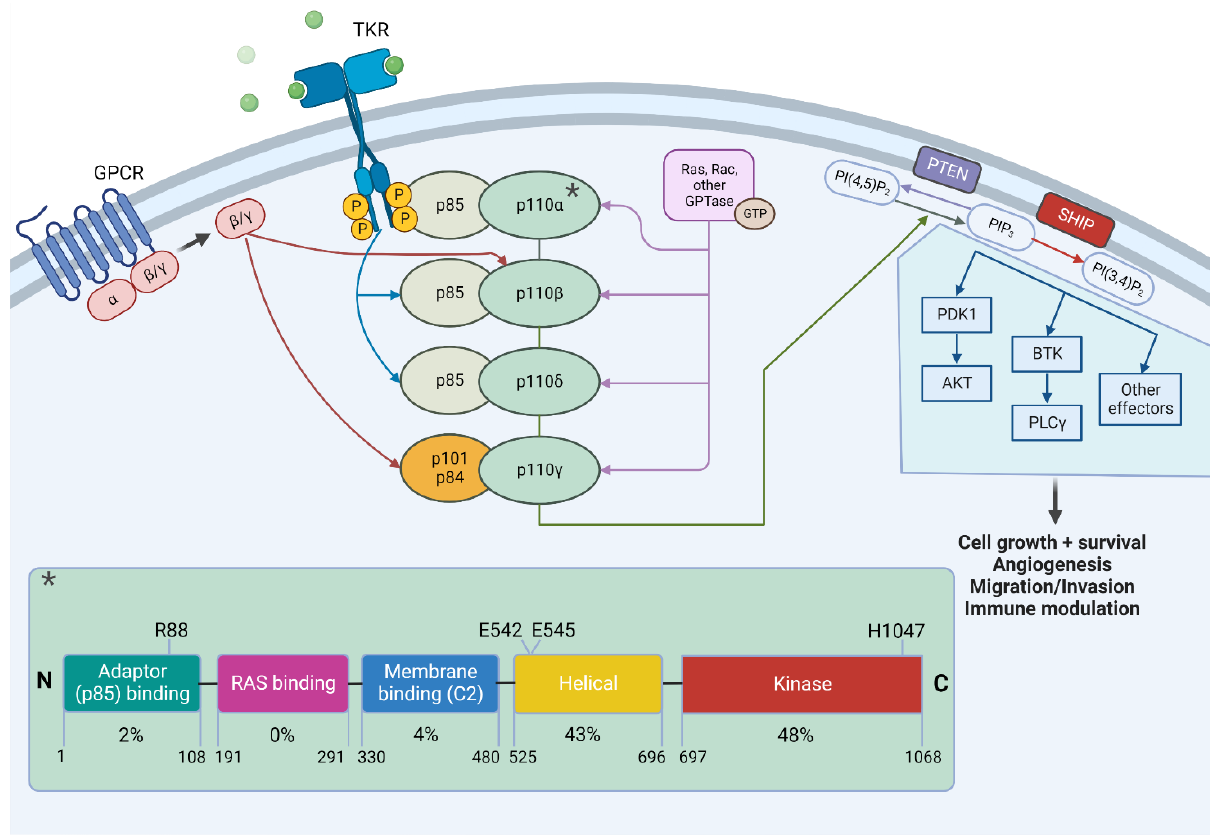
Figure 1. PI3K pathway, structure of the p110α kinase and most frequent mutations. Class I PI3Ks heterodimers consist of a catalytic subunit (four different isoforms, p110 α / β / δ / γ ) and a regulatory one (p85 and p84 isoforms). The activation of TKRs or GPCR can trigger the PI3K-AKT-mTOR pathway. PI3K phosphorylates PIP2 to PIP3, activating the downstream effectors (including AKT) responsible for cell survival and growth. PTEN antagonizes the cascade by converting PIP3 to PIP2. In the bottom square, the five domains of p110α catalytic subunit * are detailed with their relative mutation occurrence rate (see text for details). PIP2, phosphatidyl inositol 4,5 bis-phosphate; PIP3, phosphatidyl inositol 3,4,5 bis-phosphate; GPCR, G protein-coupled receptors; TKR, tyrosine kinase receptors; Ras, rat sarcoma virus; Rac, ras-related C3 botulinum toxin substrate 1; GTP, guanosine-5 ′ -triphosphate; AKT or protein kinase B (PKB); PTEN, phosphatase and tensin homolog; SHIP, Src homology 2 (SH2) domain containing inositol polyphosphate 5-phosphatase 1; PDK1, pyruvate dehydrogenase kinase 1; BTK, Bruton tyrosine kinase; PLC, phospholipase C. Figure created with BioRender.com. “*” is referred to the catalytic